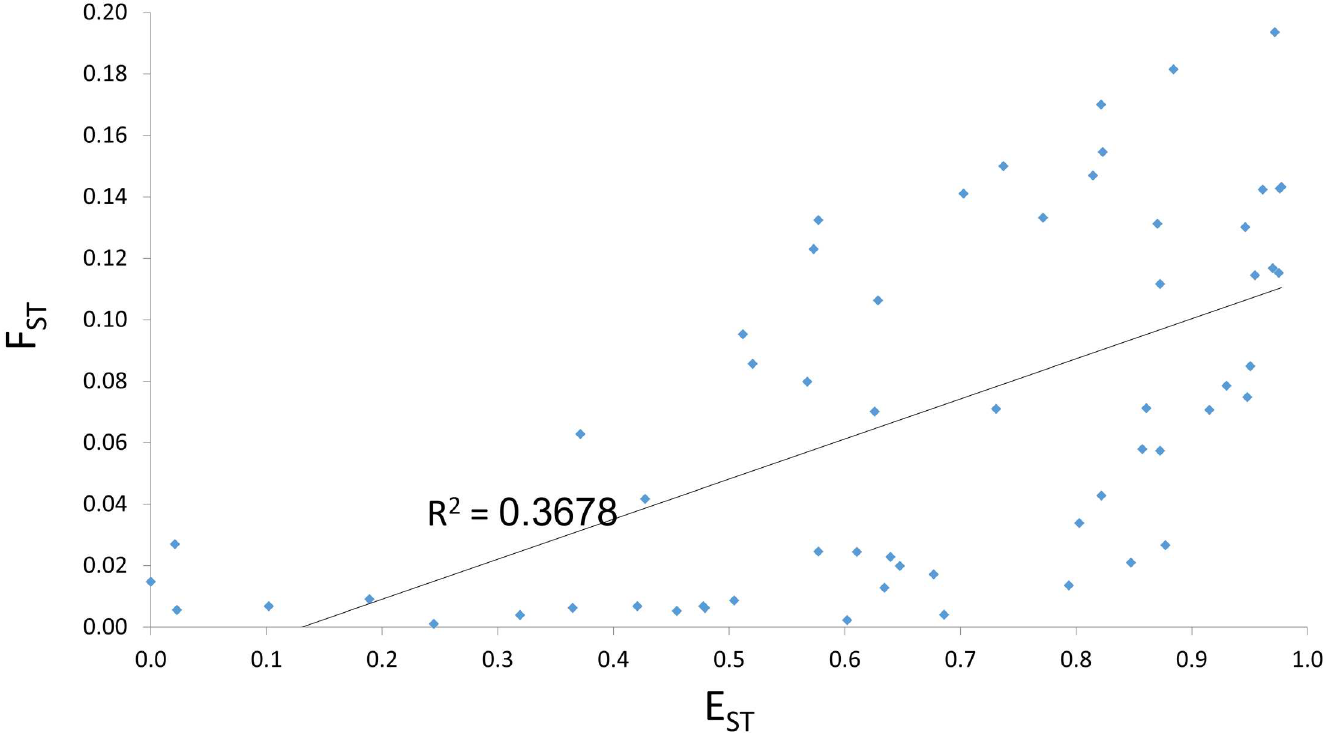
Fig 4. Positive correlationbetweenF ST and E ST . R = 0.61.Note that E ST has a much broaderrange, spanning nearlythe entire0–1 intervalwhile F ST only goes as high as 0.2 in these HGDP populations.